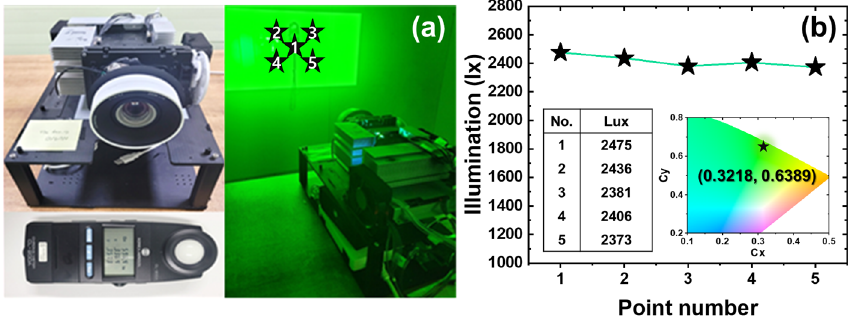
Figure 5. ( a ) Image of a beam projector in operation with the manufactured ceramic phosphor mounted; ( b ) illumination measured at five designated locations at a distance of 1.5 m.